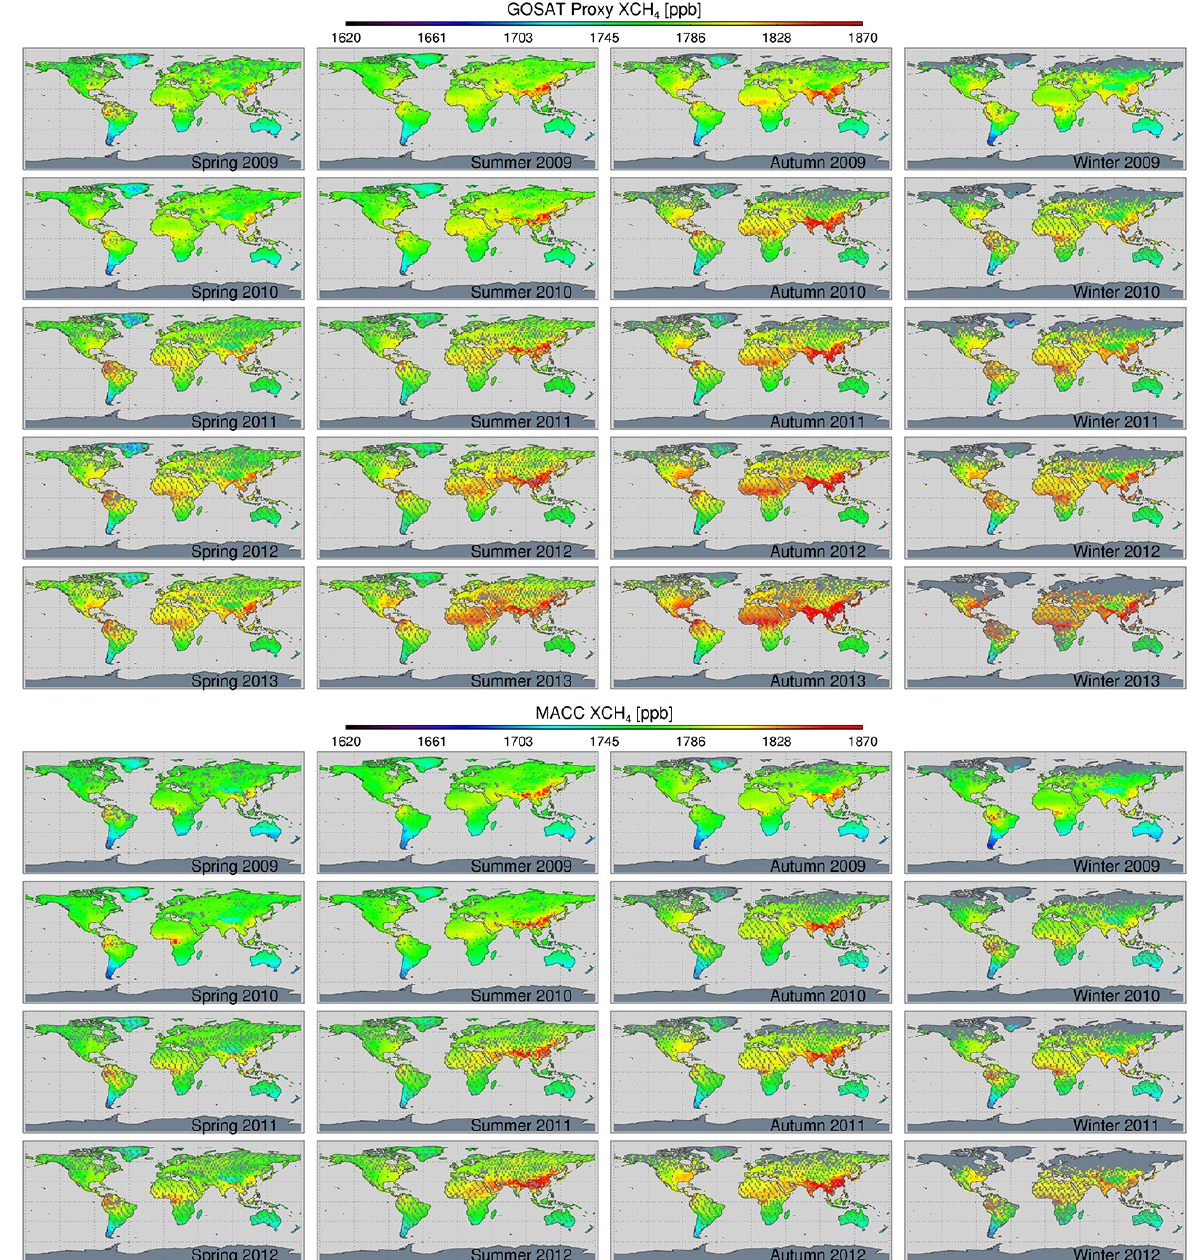
Figure 1. Seasonal global maps of the University of Leicester GOSAT Proxy XCH 4 (top) and the MACC-II (bottom) model XCH 4 data (v10-S1NOAA). Both model and observation show the XCH 4 variability in time and space, in particular with the large emissions of methane from wetland and rice cultivation over India and S.E. Asia. Note that GOSAT changed their pointing pattern in August 2010 from five across-track points to three across-track points, resulting in a change in spatial